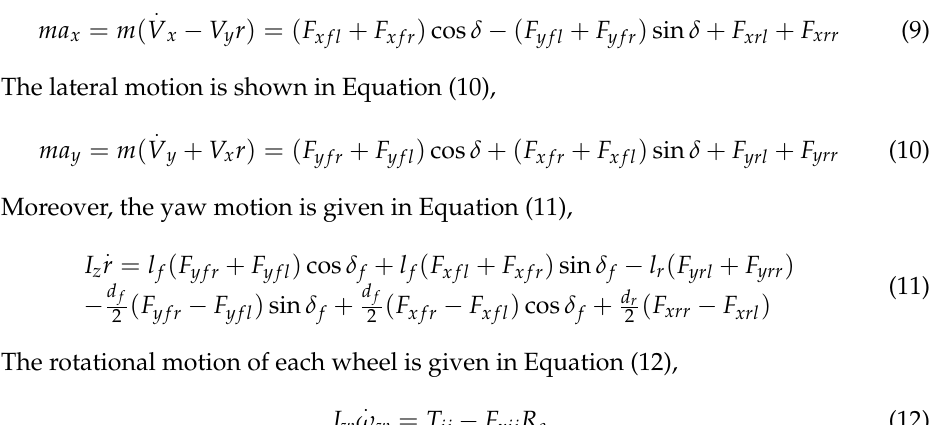
Figure 2. The 7-DOF vehicle